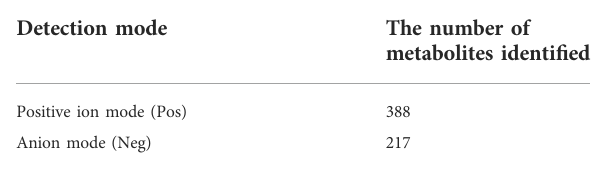
TABLE2Numbersofmetabolitesdetectedinpositiveandnegativeion